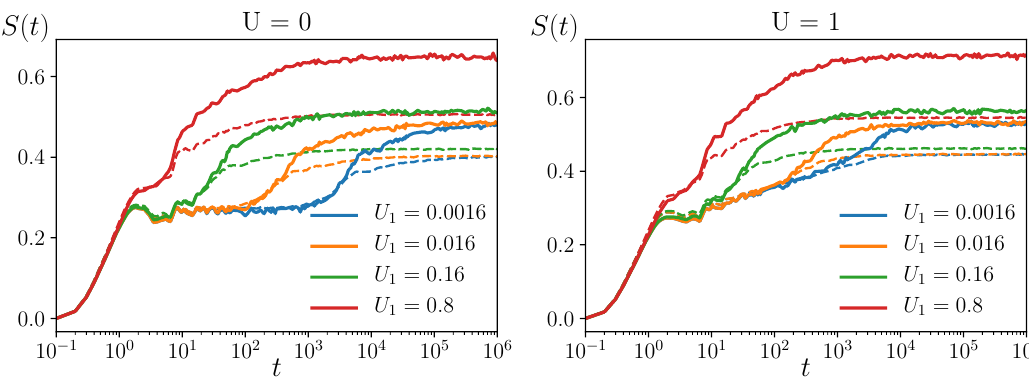
Figure 6: Entanglement entropy as a function of time for U = 0 (left) and U = 1 (right), W = 8 and for different values of U (see color code in the legenda). The 1 dashed and thick lines correspond to K = 12 and K = 16, respectively.